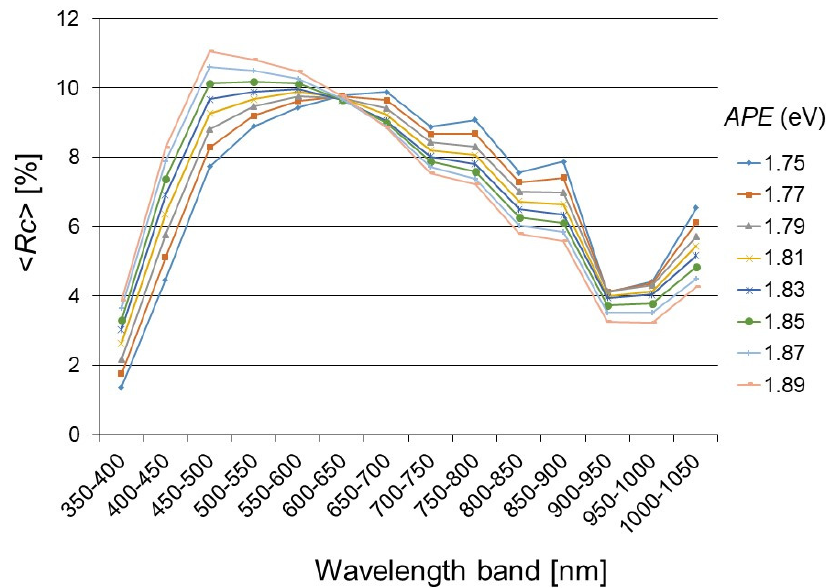
Figure 3. Mean values of relative contributions to DNI—integrated from 350 to 1050 nm—across all 50-nm bands for spectral measurements binned in 0.02-eV-width APE intervals over the range 1.75–1.89 eV (central values), using direct irradiance spectra recorded at Jaén.